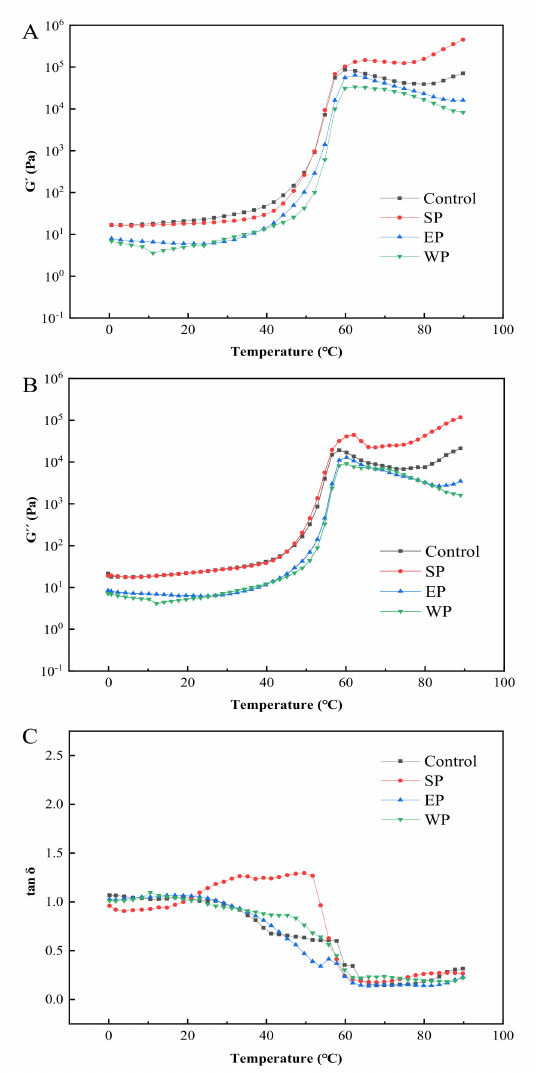
Figure 2. Effect of added proteins on the rheological behavior of batter. ( A – C ) refer to the storage modulus (G (cid:48) ), the loss modulus (G (cid:48)(cid:48) ), and the loss tangent (tan δ ), respectively; the control refers to the batter without protein added; SP, EP, and WP represent soy protein, egg white protein, and whey protein,